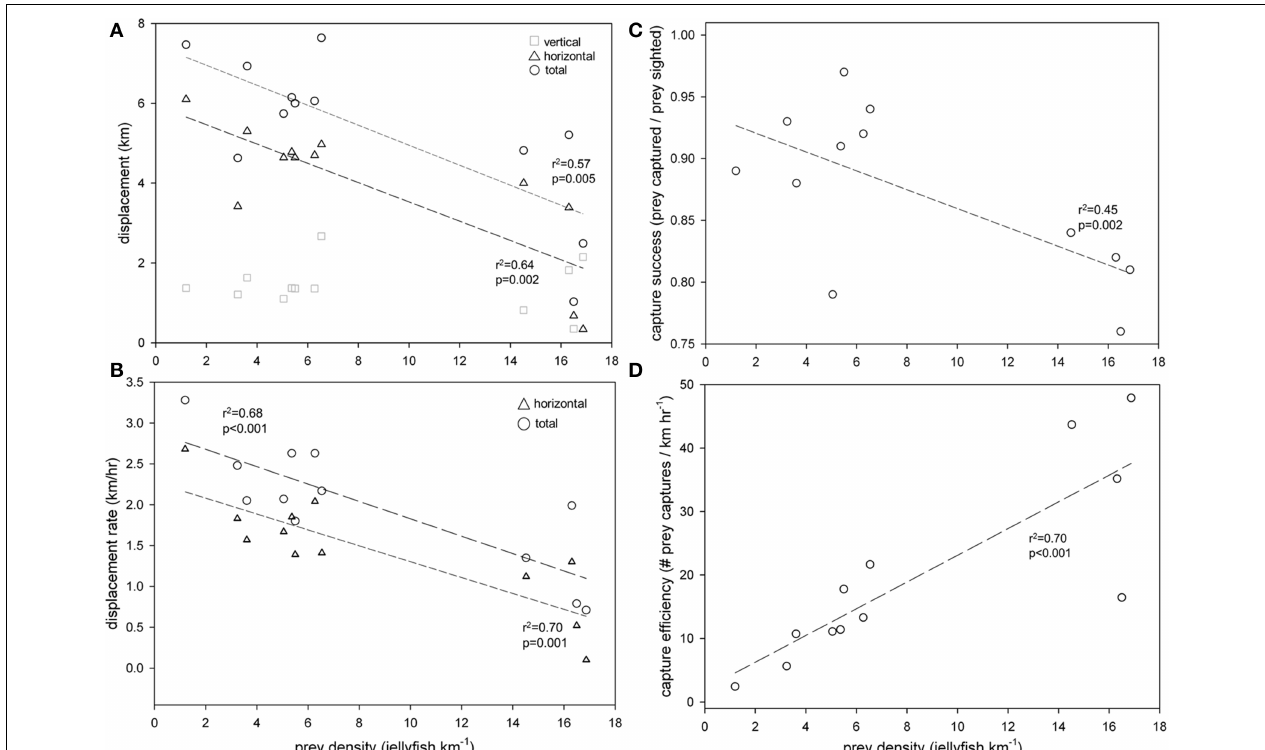
FIGURE 4 | Prey density (number of jellyfish sighted km − 1 ) was inversely related to (A) displacement (km) and (B) displacement rates (km h − 1 ) of leatherback turtles ( Dermochelys coriacea ) foraging in the Northwest Atlantic Ocean off Nova Scotia, Canada. Total displacement (and rate) included both horizontal (straight-line